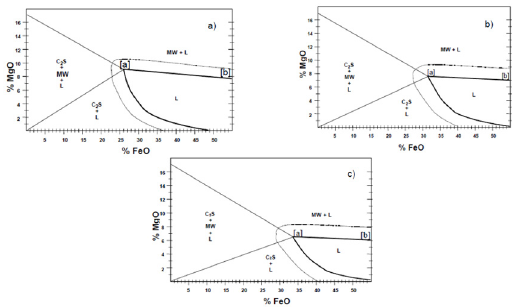
Figure 8: Isothermal saturation diagrams for different basicities (a) B =2.0; (b) B =2.5; (c) B =3.0. 3 3 3 uses Gibbs energy minimization to calculate general phase diagram sections thermodynamically using the zero phase fraction line concept (ZPF). The program first scans the edge of the diagram to find the ends of the ZPF lines. Each line is then followed from beginning to end, using Gibbs energy minimization to determine the point at which a phase is just on the verge of being present 23 .